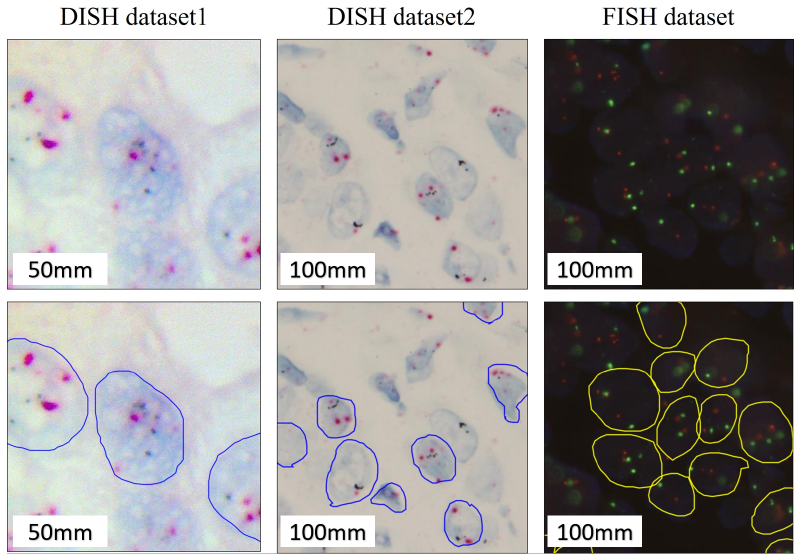
Figure 1. An illustration of DISH and FISH images including unclear and blurry cell boundaries and large variations on cell shapes and signals. ( up ) a partial view of a DISH image with ( bottom ) the annotations by the